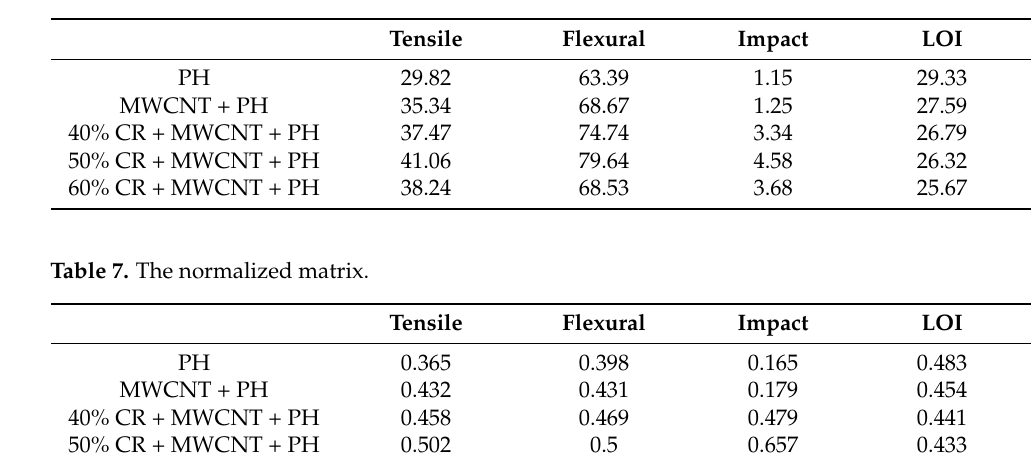
Table 6. Decision Matrix.